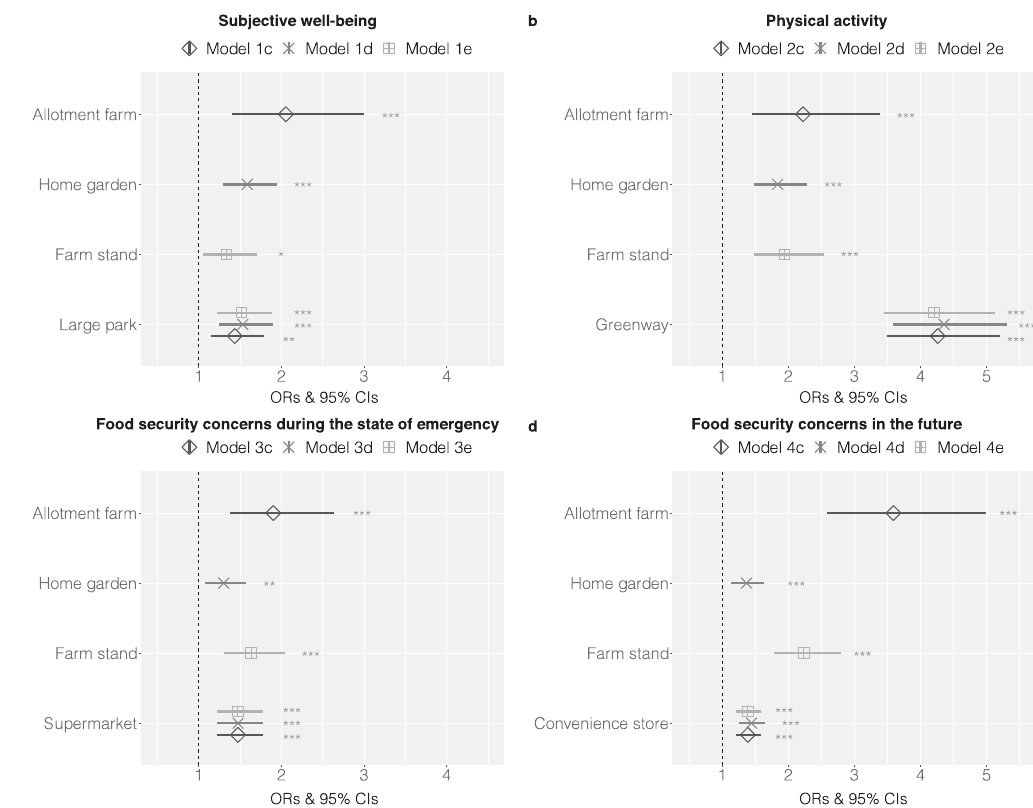
Fig. 4 The comparisons between access to local food, other urban green spaces, and other food purchasing places. a – d The associations of subjective well-being with each type of local food access and large parks ( a ), physical activity with each type of local food access and greenways ( b ), food security concerns during the state of emergency with each type of local food access and supermarkets ( c ), and food security concerns in the future with each type of local food access and convenience stores ( d ). The diamond ( ◊ ), cross (x), and square ( □ ) symbols indicate the ORs. The vertical dashed line is the reference line and is set to one. The error bars represent the 95% CIs. Predictors are interpreted to be signi fi cant if their 95% CIs do not cross one line. The signi fi cant results are shown as follows: * p < 0.05, ** p < 0.01, and *** p <